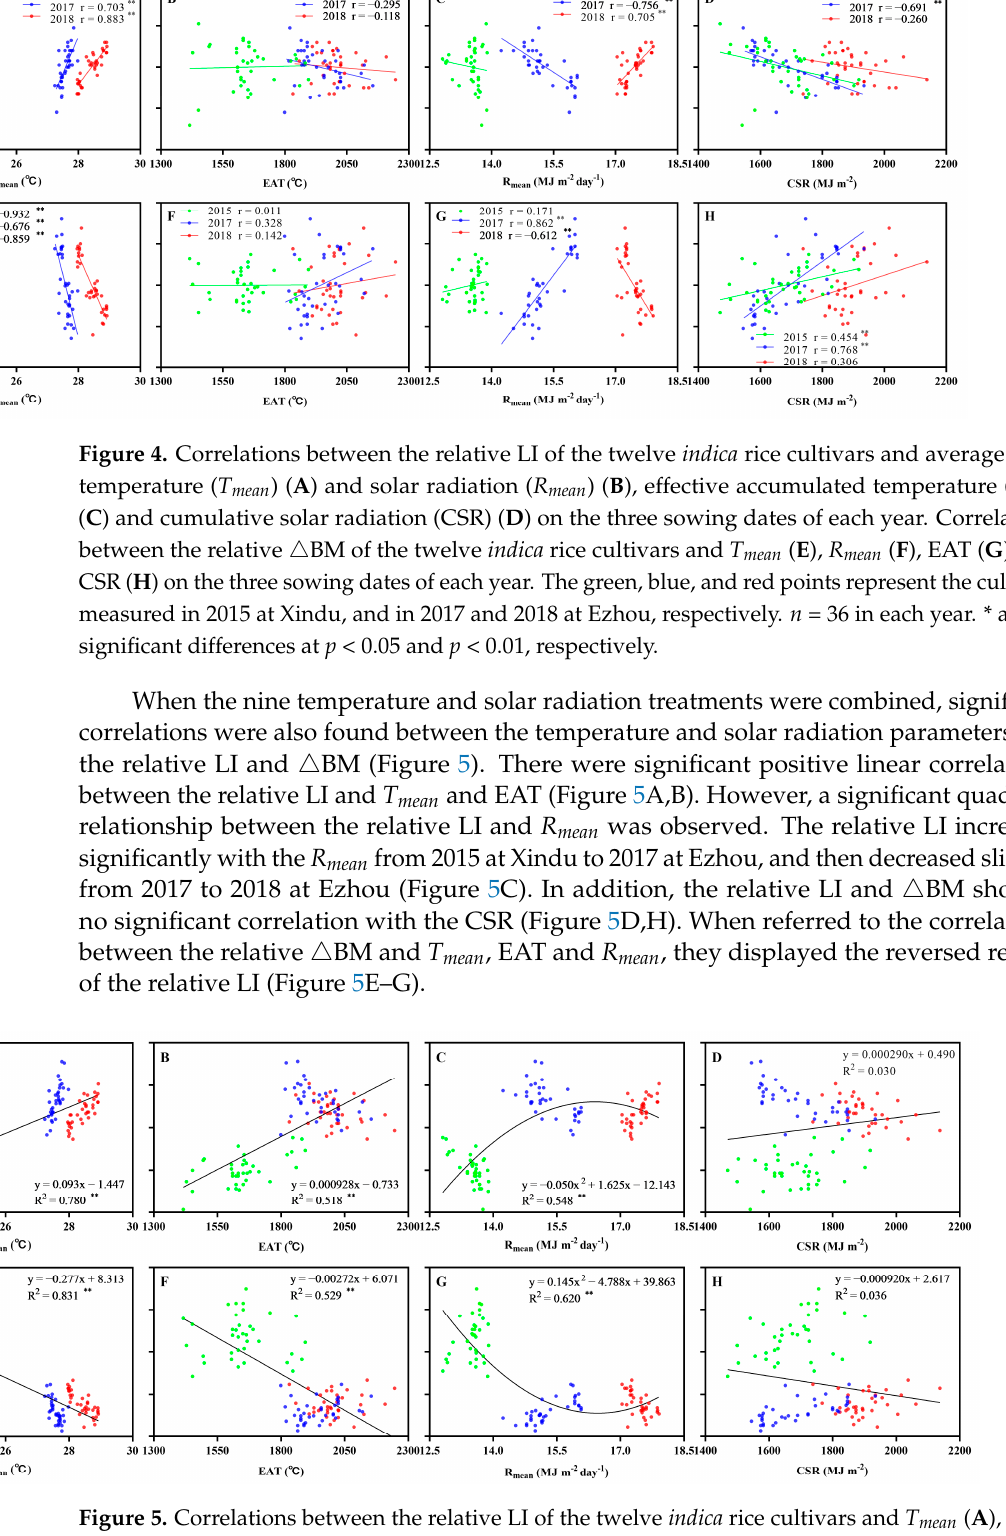
Figure 5. Correlations between the relative LI of the twelve indica rice cultivars and T mean ( A ), R mean ( B ), EAT ( C ), and CSR ( D ) on all the sowing dates across two locations and three years. Correlations between the relative △ BM of the twelve indica rice cultivars and T mean ( E ), R mean ( F ), EAT ( G ), and CSR ( H ) on all the sowing dates across two locations and three years. The green, blue, and red points represent the cultivars measured in 2015 at Xindu, and in 2017 and 2018 at Ezhou, respectively. n = 36 in each year. **, significant differences at p < 0.01.